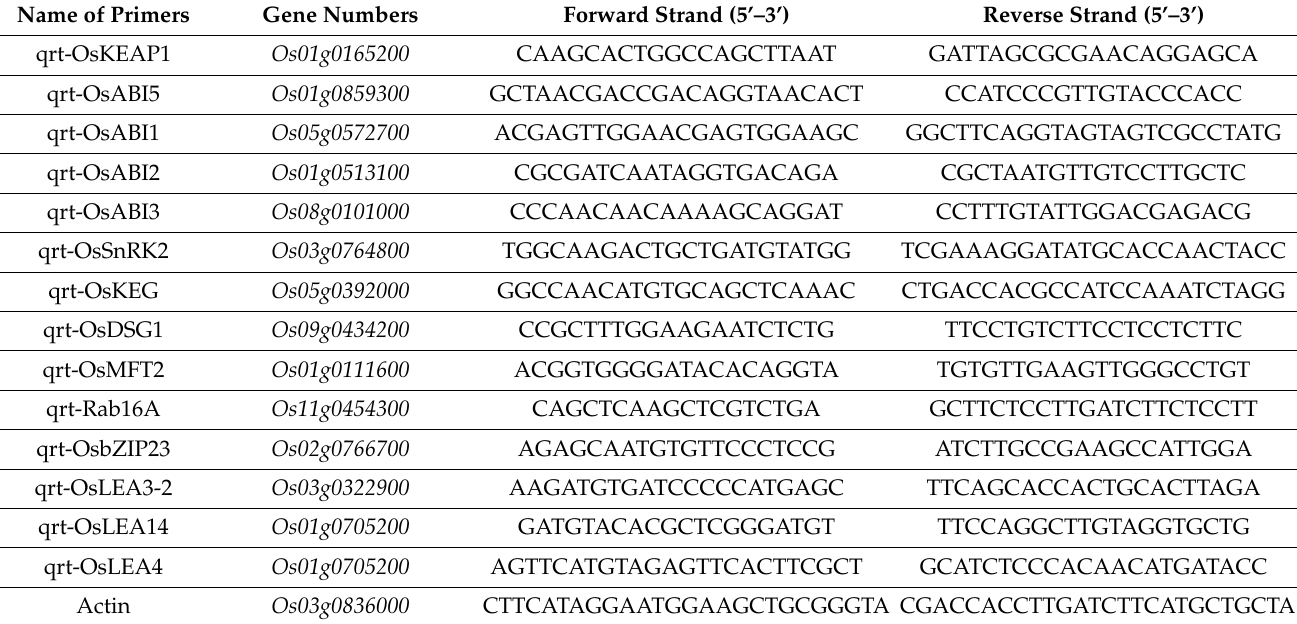
Table 2. Primers used for the qPCR